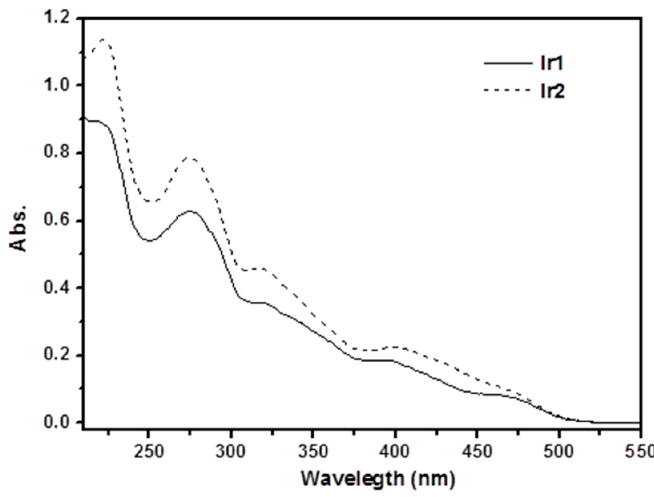
Figure 6. UV Vis absorption spectra of coordination compound Ir1, Ir2 acetonitrile solution (2.0 × 10 –5 mol/L).